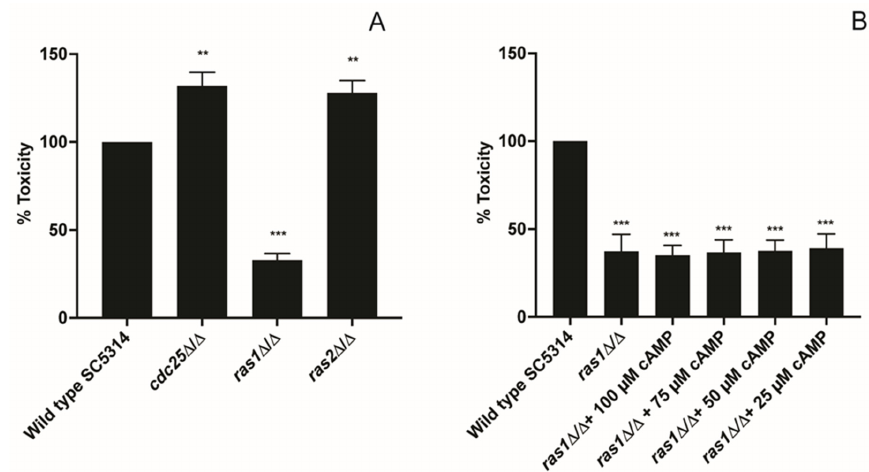
Figure 3. The cytotoxicity towards HeLa cells is influenced by Cdc25 and Ras1 but works independent from cAMP. HeLa cells were seeded at a concentration of 10,000 cells/well. C. albicans cells were added at OD 600 1. After an incubation of 24 h, the released amount of LDH from the HeLa cells was measured. ( A ) The toxicity of the WT was compared with a cdc25 , ras1 , and ras2 mutant. ( B ) The effect of cAMP on the toxicity of the ras1 mutant towards HeLa cells was tested. The values of the deletion strains are normalized relative to the WT strain which has 100% toxicity towards HeLa cells. The results show the average of three independent experiments each consisting of one biological repeat and three technical repeats with the error bars representing the SEM. Statistical analysis was done by using an ANOVA test with Bonferroni correction. A significant difference was found when ** p = 0.0021 and *** p = 0.0002.